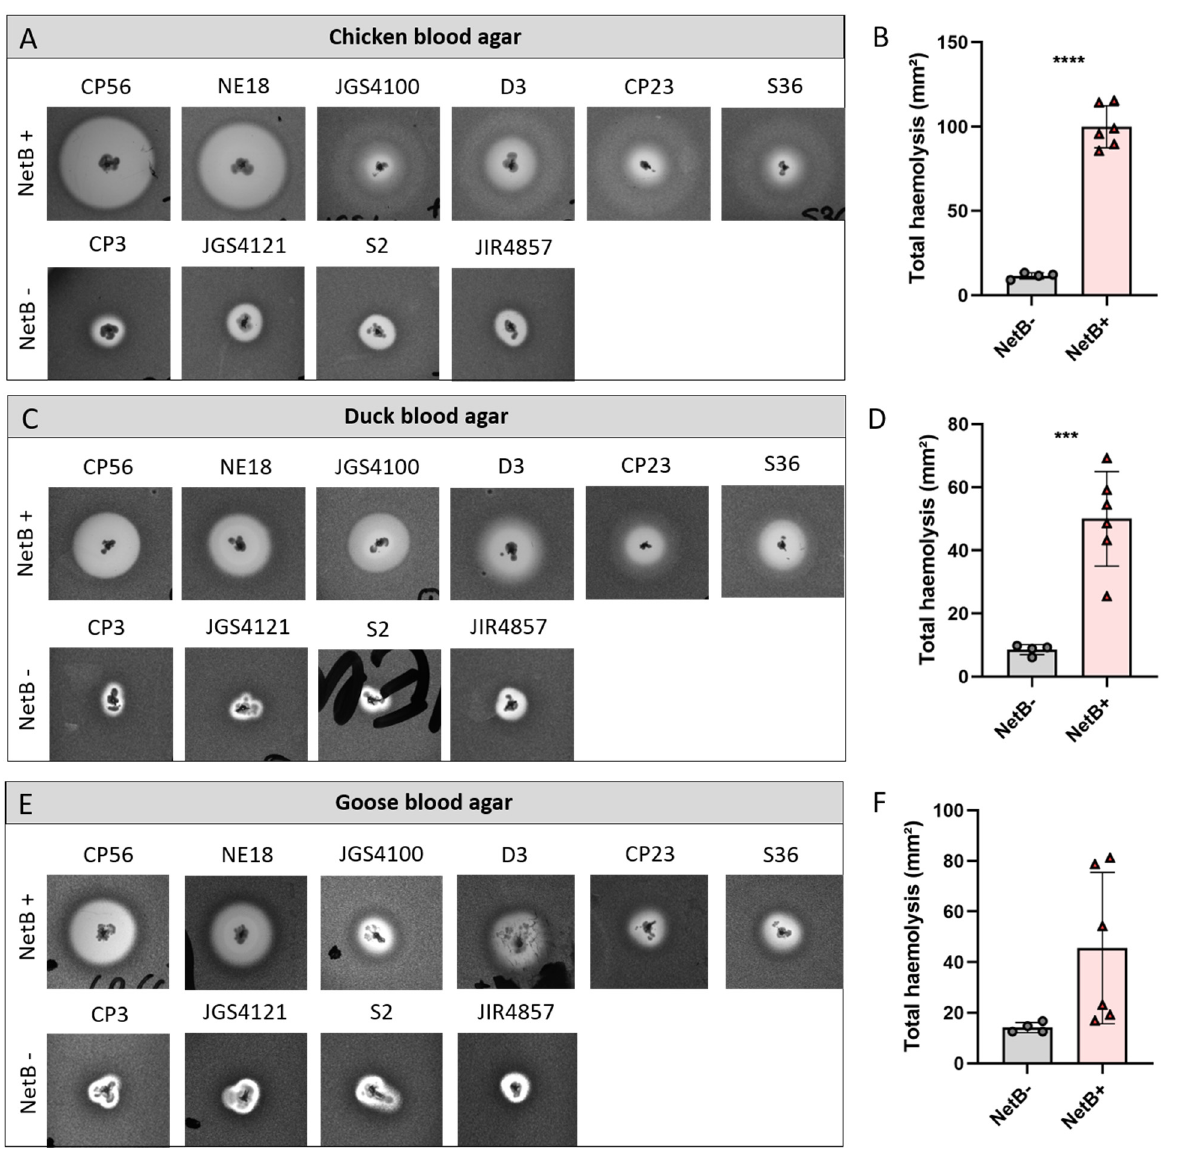
Figure 3. Haemolysis produced by six NetB-positive (CP56, NE18, JGS4100, D3, CP23 and S36) and four NetB-negative C. perfringens strains (CP3, JGS4121, S2 and JIR4857) on Columbia agar supplemented with 5% chicken blood ( A , B ), duck blood ( C , D ) or goose blood ( E , F ). The graph shows the total haemolysis induced by each strain ( B , D , F ). Grey dots represent a NetB-negative strain, red triangles represent a NetB-positive strain. *** p < 0.001; **** p < 0.0001.